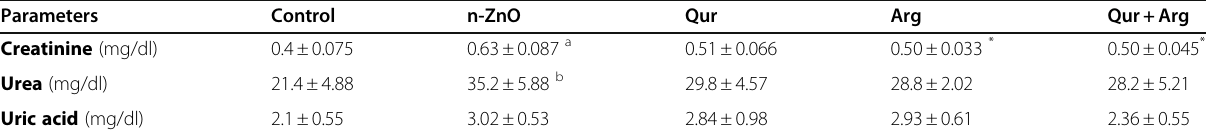
Table 4 Effect of Qur and/or Arg treatment on serum creatinine, urea, and uric acid levels in intoxicated rats with a high dose of n-ZnO particles